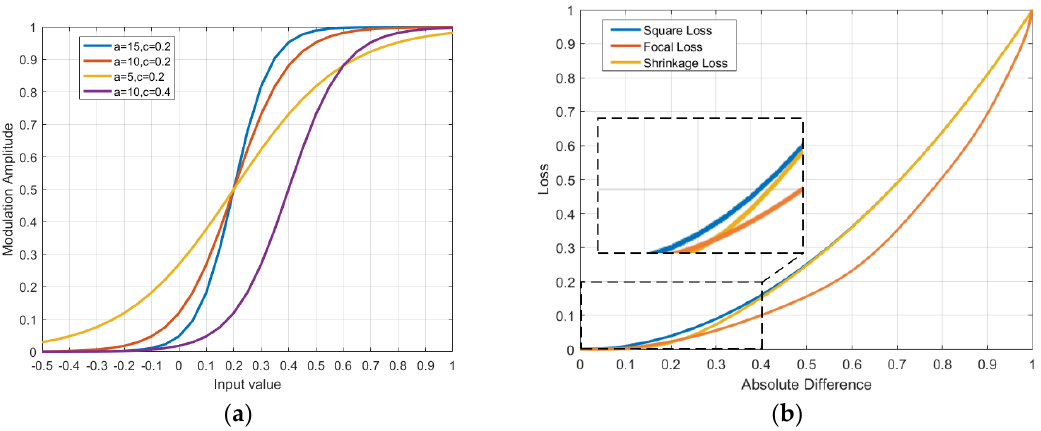
Figure 12. ( a ) Modulating factors in (5) with different hyper-parameters. ( b ) Comparison between the square loss (L2), focal loss (L3), and the proposed shrinkage loss.